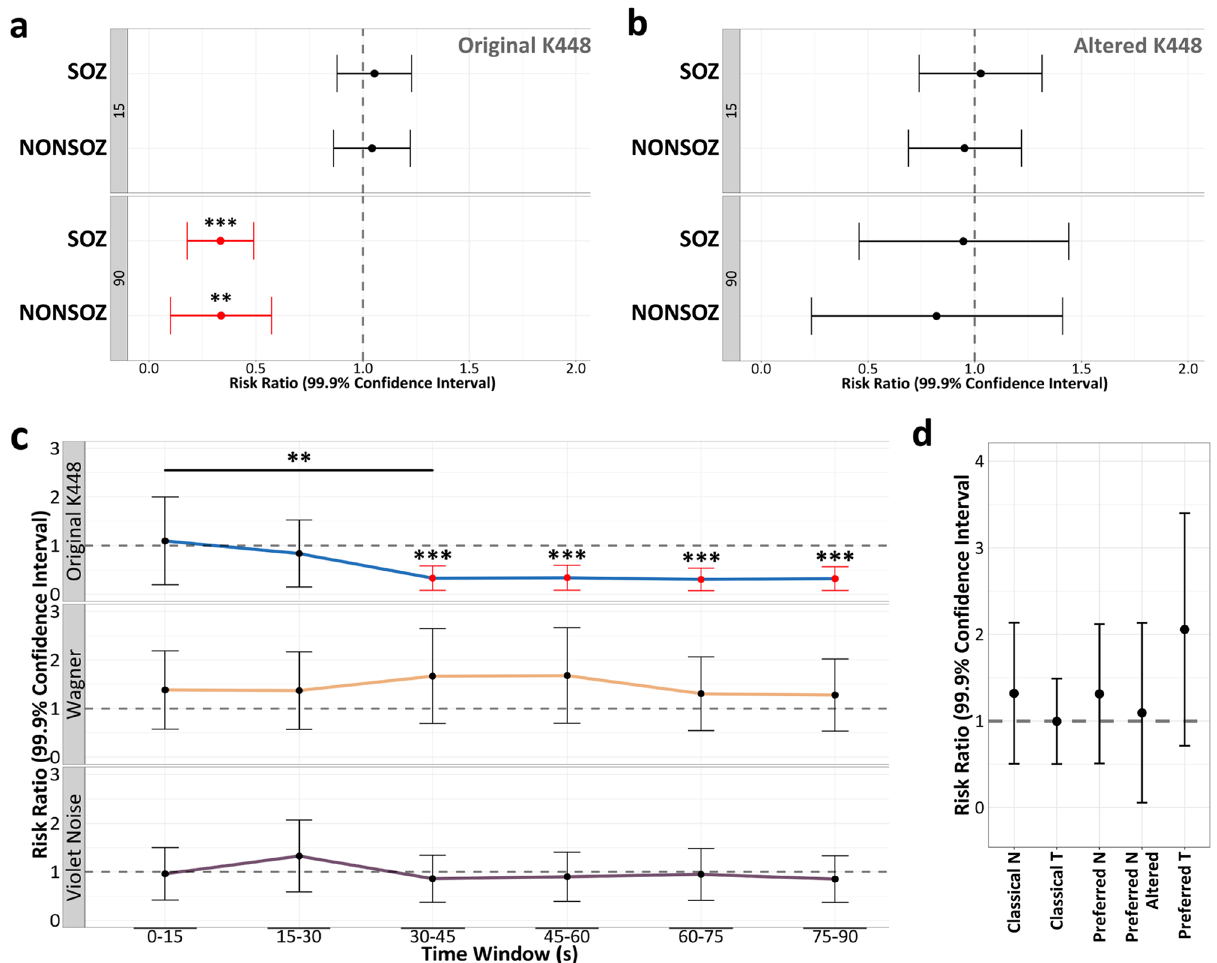
Figure 3. Reduced global IED rates are dependent on the duration of music exposure. ( a ) GEE models showed that the original version of K448 was the only stimulus effective at reducing IEDs with at least 90-s of exposure. ( b ) Nonsignificant reductions were observed for the altered versions of K448 (top = modulatedK448, bottom = filteredK448). ( c ) Partitioning the 90-s window of Mozart’s original K448 revealed that IED reductions only began after 30-s of exposure. There was a significant IED reduction between the 0–15 and 30–45 windows ( p = 0.004). Control stimuli (musical control = Wagner’s Lohengrin [ Prelude to Act I ], nonmusical control = violet noise) demonstrated nonsignificant IED reductions for each time window. ( d ) All other musical stimuli presented to Group 90 showed nonsignificant IED reductions. “T” or “N” following each song label indicates if the gamma-range auditory modulation spectrum of that song matched (“T”) or did not match (“N”) that of K448. “Altered” indicates signals with secondary gamma modulations. Significance at * p < 0.05, ** p < 0.01, *** p <